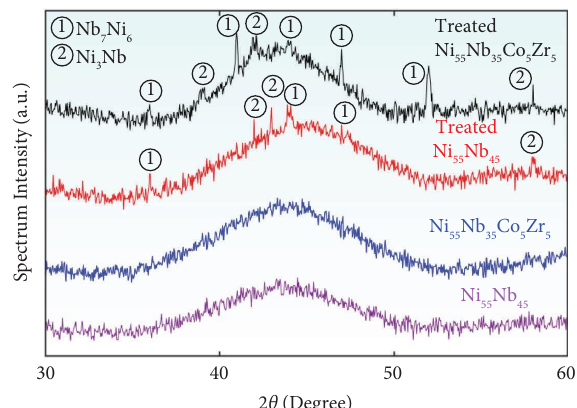
Figure 1: X-Ray difraction patterns for raw and treated